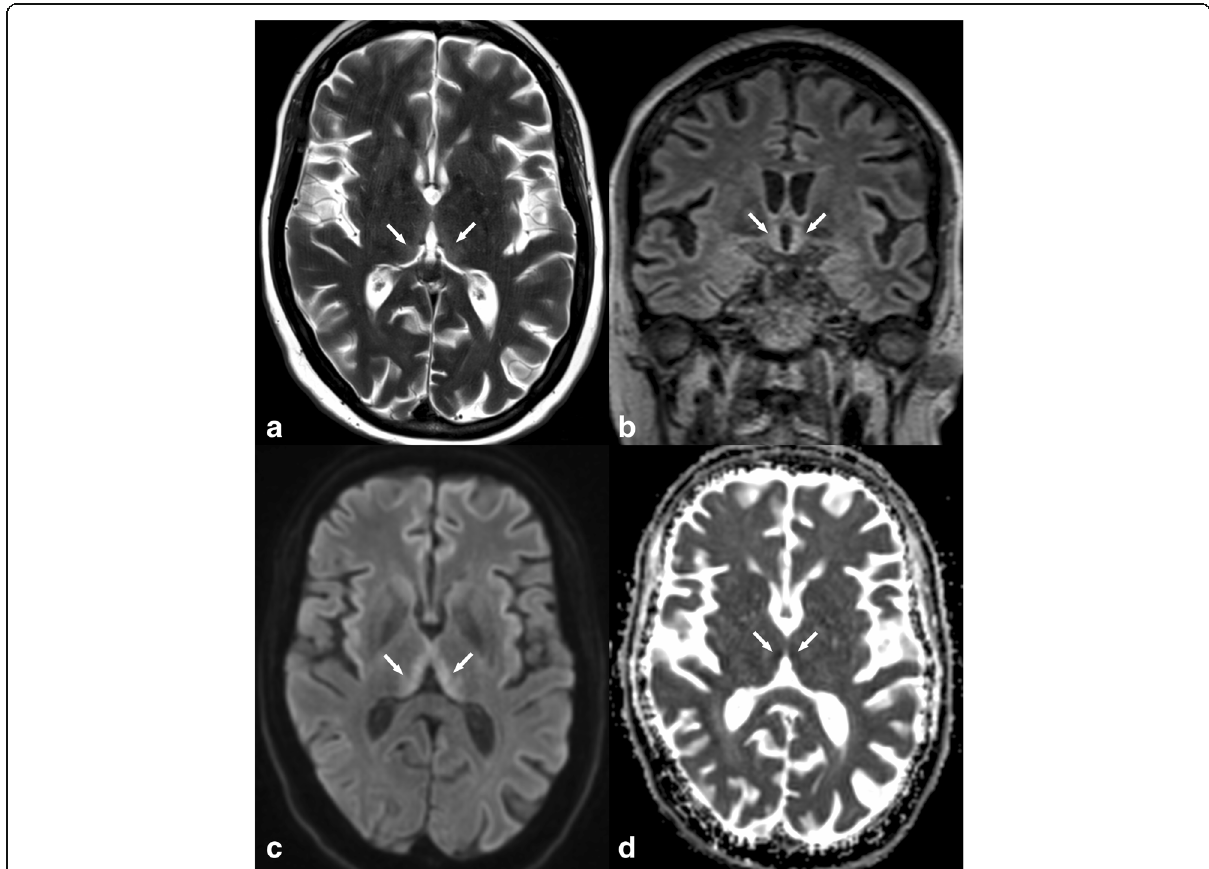
Fig. 5 Axial FSE T2 ( a ) and coronal FLAIR ( b ) illustrate hyperintensity surrounding the third ventricle (arrows). These abnormalities are associated with diffusion restriction (arrows in c and d